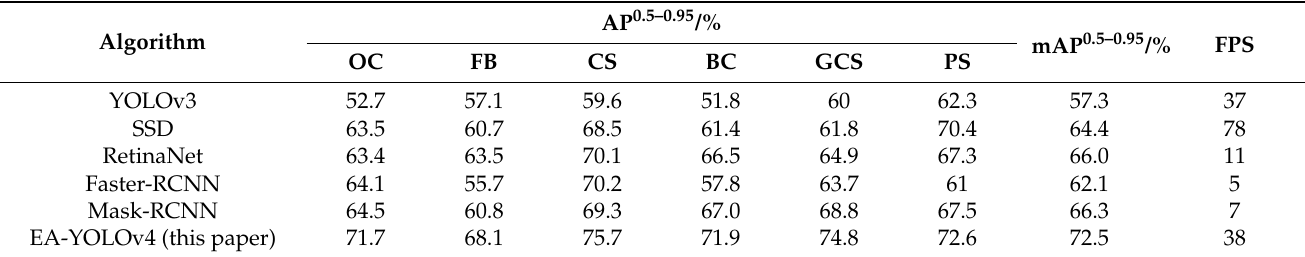
Table 4. Comparison results between EA-YOLOv4 and other mainstream